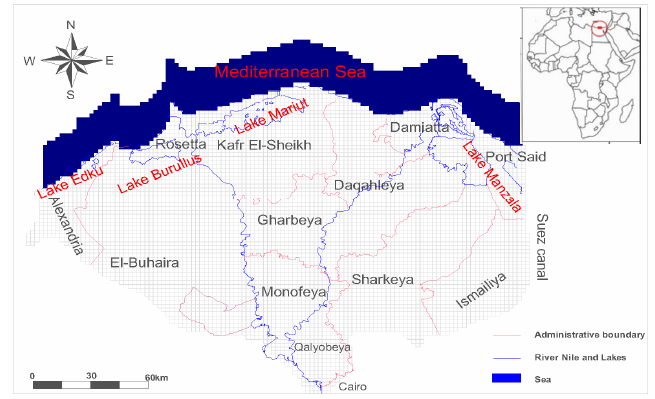
Figure 1. Location map of different governorates in the Nile Delta Aquifer (NDA).